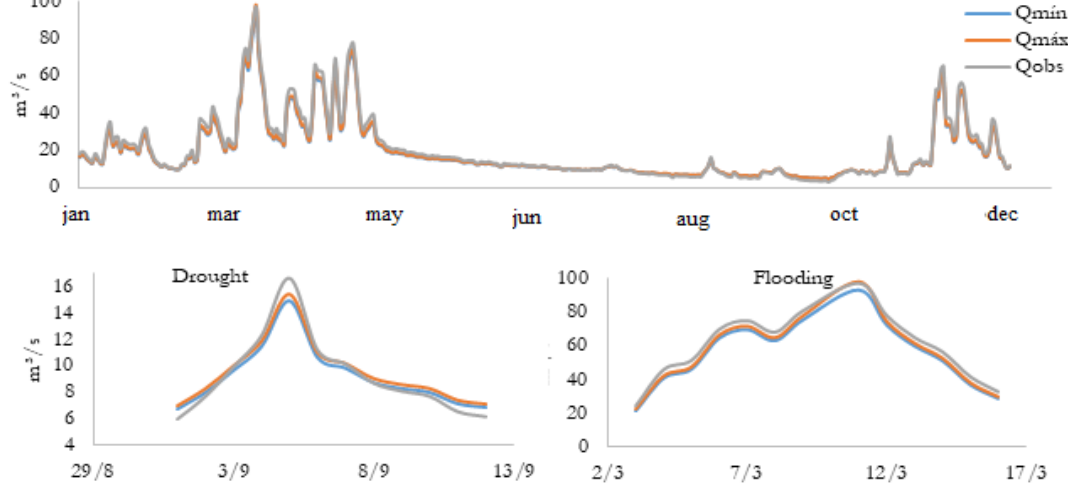
Figure 14. Annual discharge of 2014—DREAM.